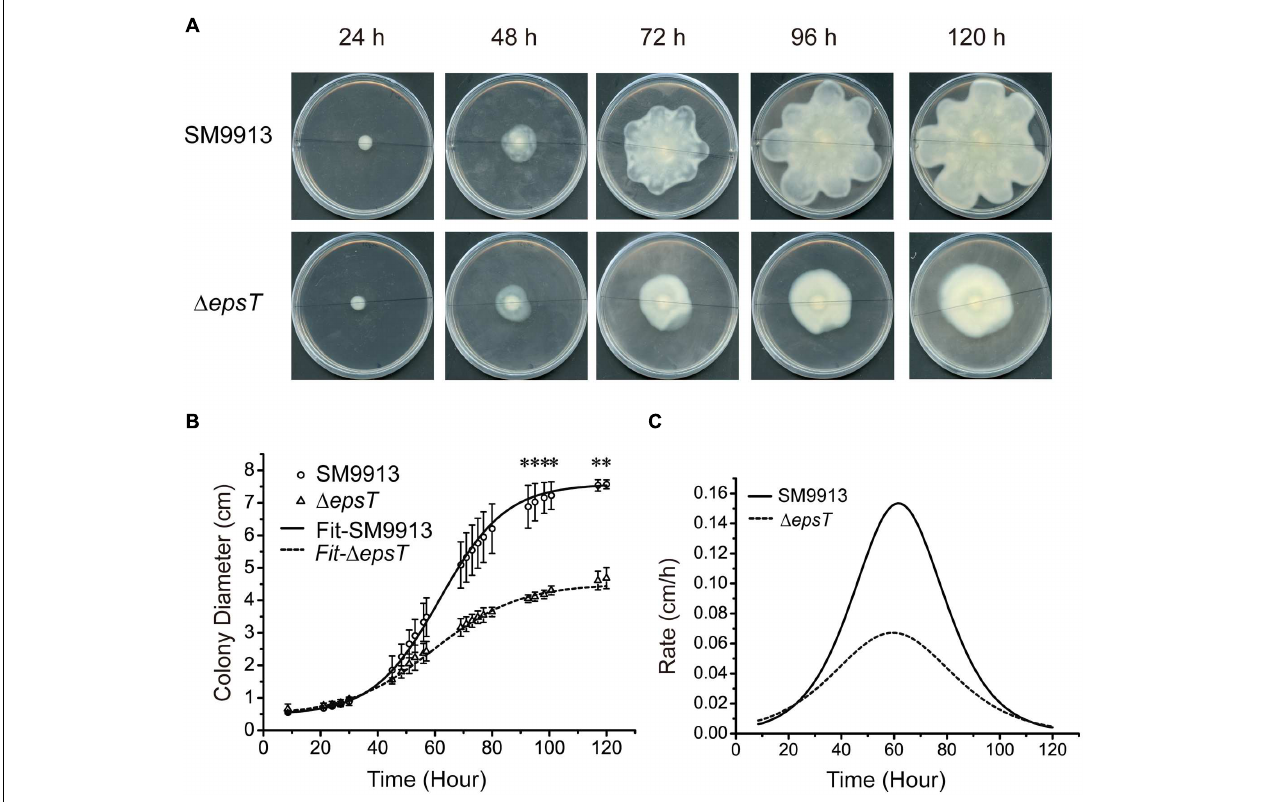
FIGURE 5 | Analyses of the swarming modes of wild SM9913 and (cid:49) epsT . (A) Swarming colonies of SM9913 and (cid:49) epsT at different incubation time. Pictures are a representative of three independent experiments. (B) Colony expansion curves of wild SM9913 and (cid:49) epsT fitted with growth equation based on measured colony diameters (scatters). Data were from three independent experiments with at least three replicates (mean ± SD). P -value was calculated from t -test and the symbol ∗ indicates that the difference in colony diameter between wild SM9913 and (cid:49) epsT was significant ( P < 0.001). (C) Colony expansion rates of wild SM9913 and (cid:49) epsT . Curves were obtained by differentiating diameter with respect to time using fitted curves.